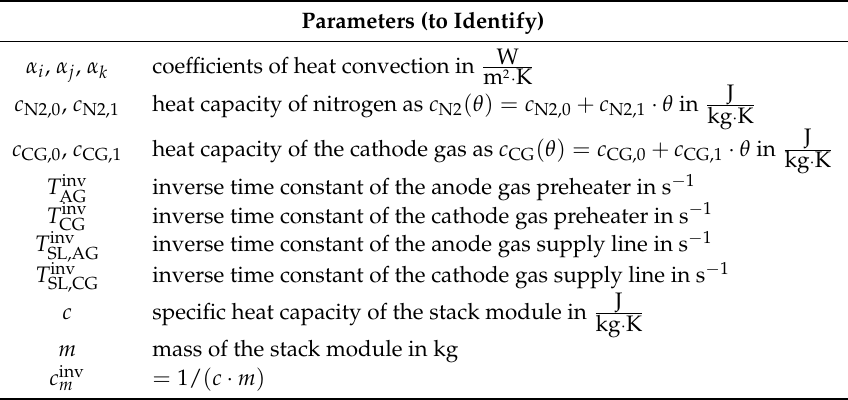
Table 2. Model parameters, control inputs and state